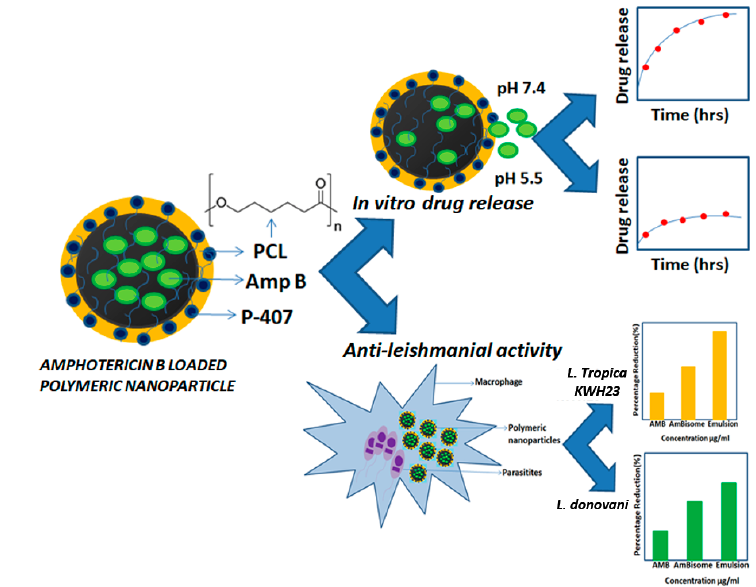
Figure 1. Overview of the experimental work: From Amphotericin B (Amp B) loaded polymeric nanoparticles preparation to in vitro drug release and anti-leishmanial activity.